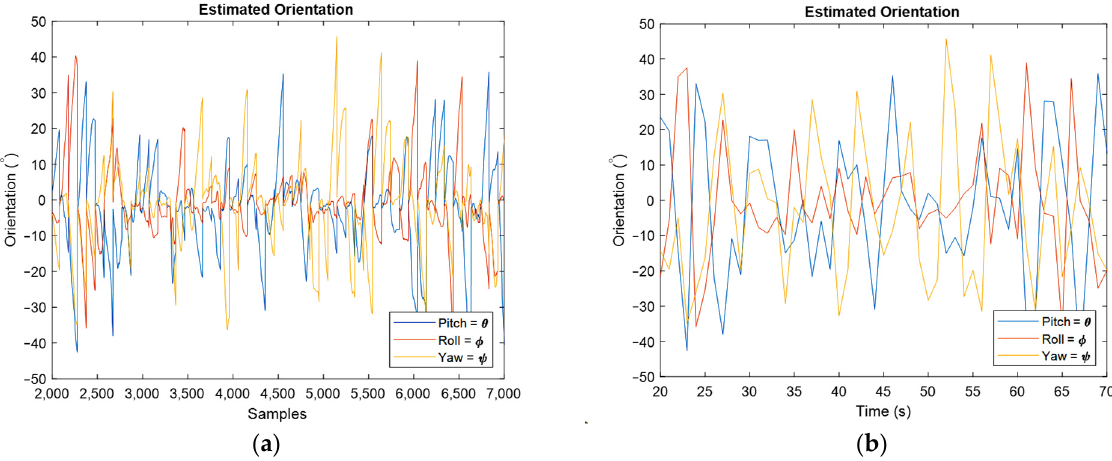
The following results are for moving IMU, and first, the orientation estimation is